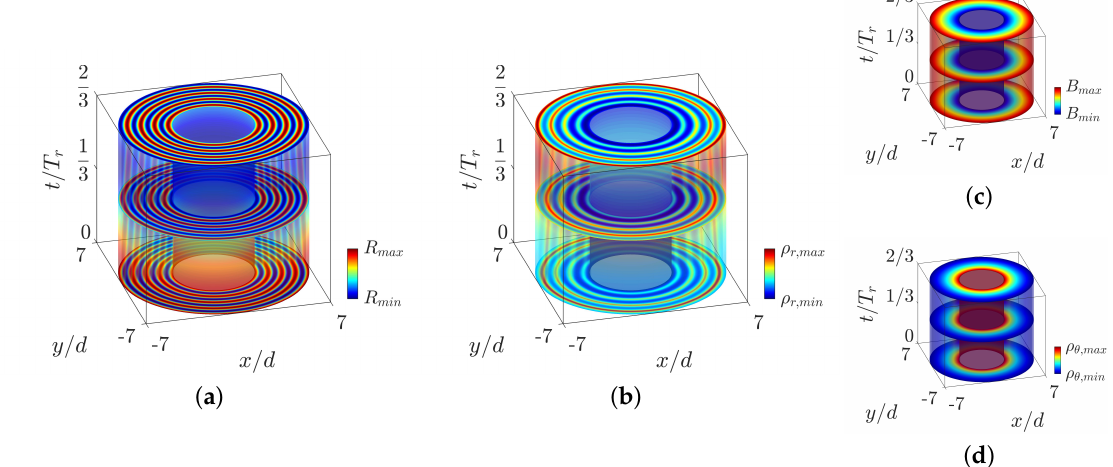
Figure 4. Schematic representation of the space–time varying properties. ( a ) Graphical representation of R ( r , θ , t ) . ( b ) Space–time varying radial tension ρ r ( r , θ , t ) . The properties are periodic in space and traveling toward the inner shell or the outer shell depending on the modulation direction. ( c ) Bulk modulus distribution B ( r , θ , t ) . ( d ) Graphical representation of the spatially varying tangential density ρ θ ( r , θ , t ) .